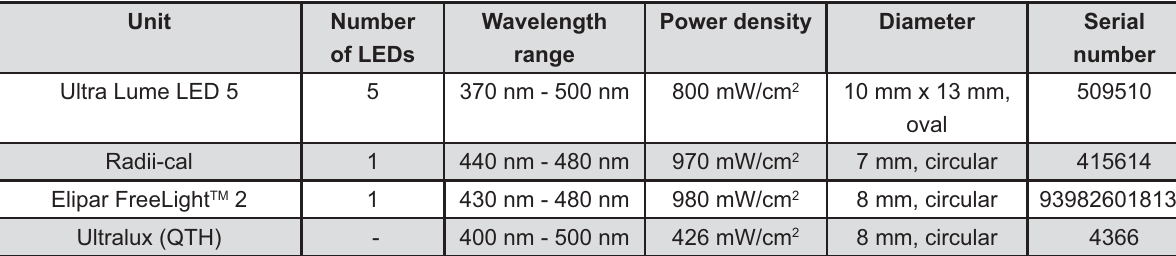
Figure 2- Characteristics of light-curing units used in this to regularize the external surface of the samples.